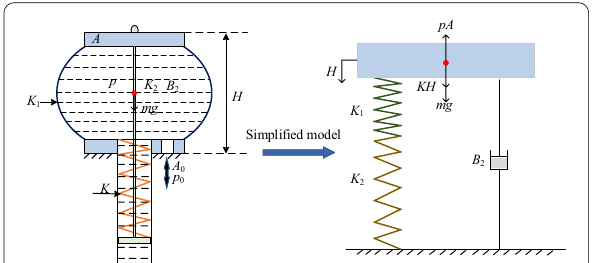
Figure 7 The dynamic model of the VVPR